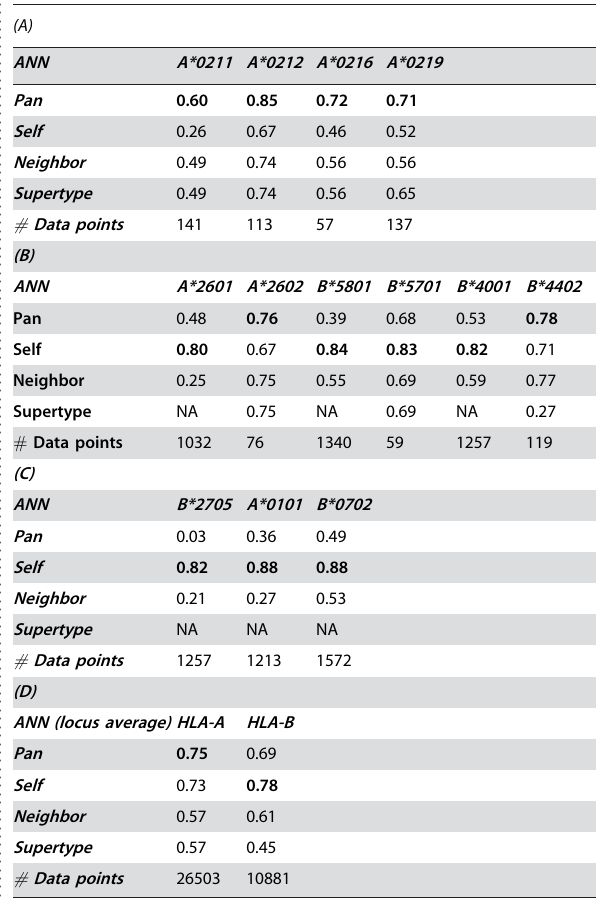
Table 1. Comparison of various validated predictors